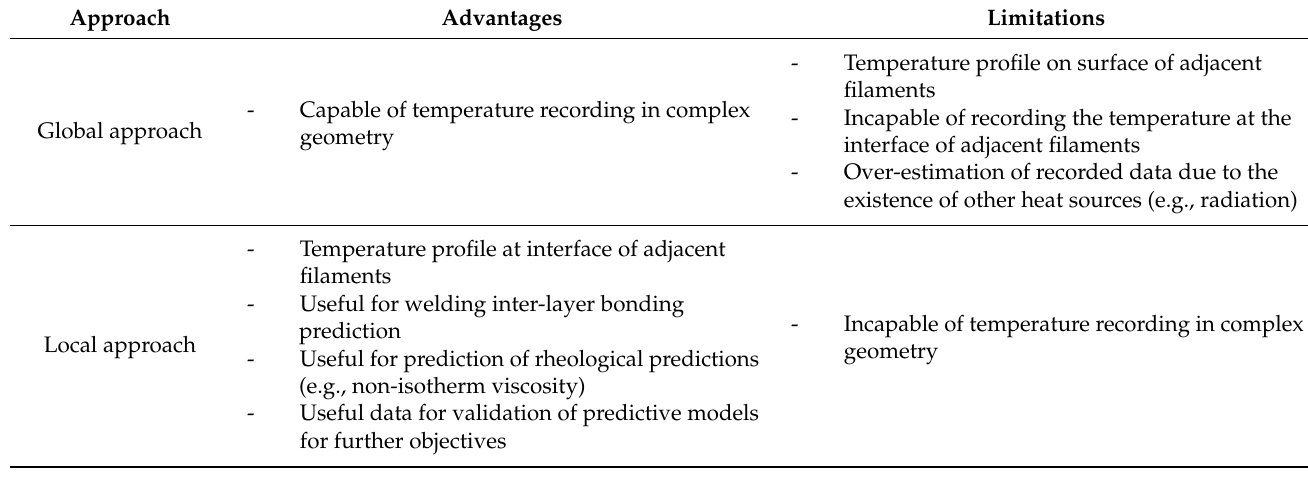
Table 4. Summary of in-process monitoring of temperature profile